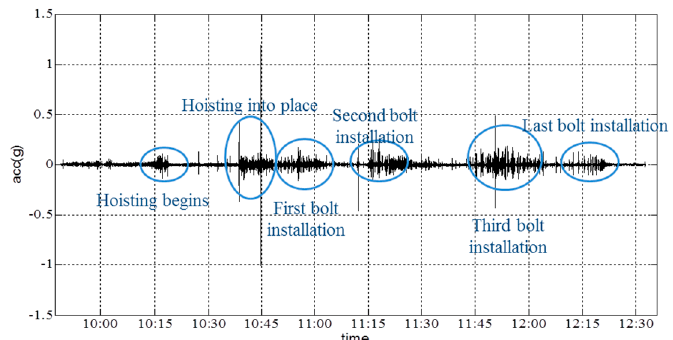
Figure 17. Vertical-acceleration time-history curve of the girder during hoisting.